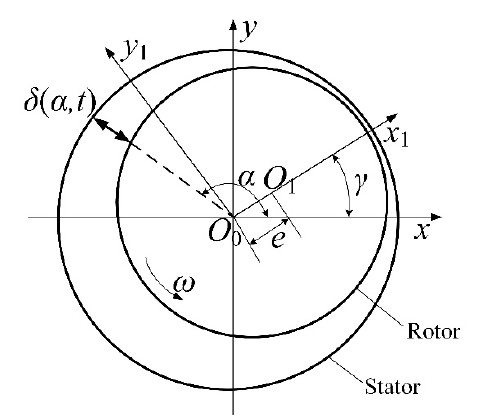
Figure 1. Schematic diagram of the generator rotor eccentricity phenomenon.